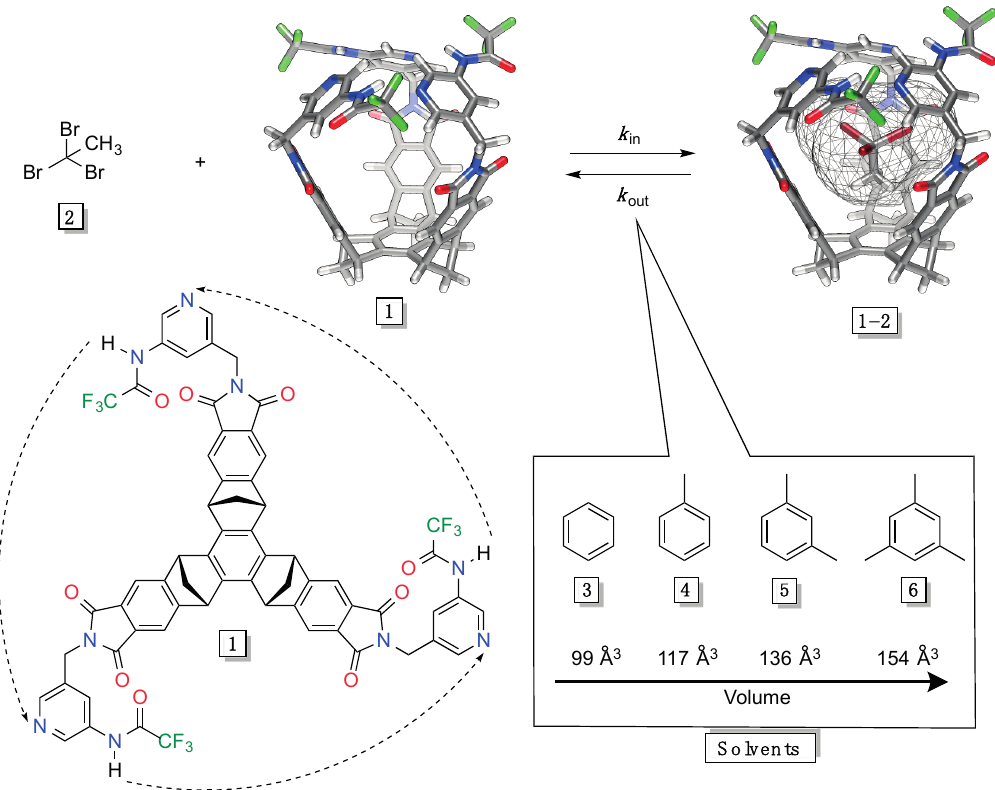
Figure 1. Energy-minimized (MMFFs, Spartan) and chemical structures of gated molecular basket 1 (V = 220 Å 3 ). The kinetics of in/out trafficking of guest 2 (V = 107 Å 3